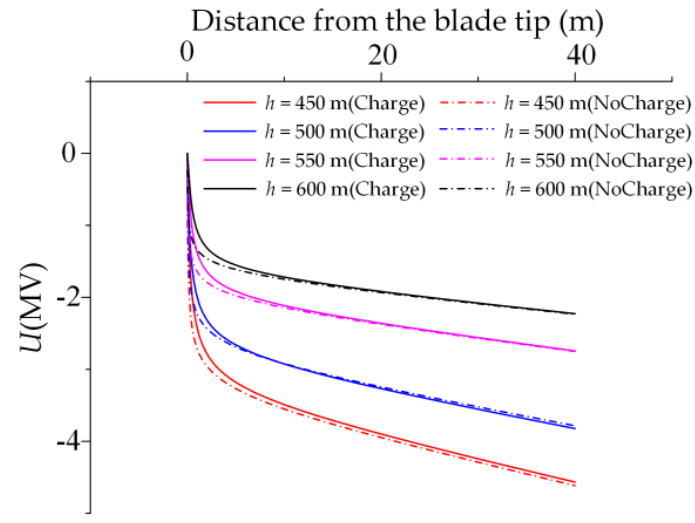
Figure 3. Space potential distribution near the blade.